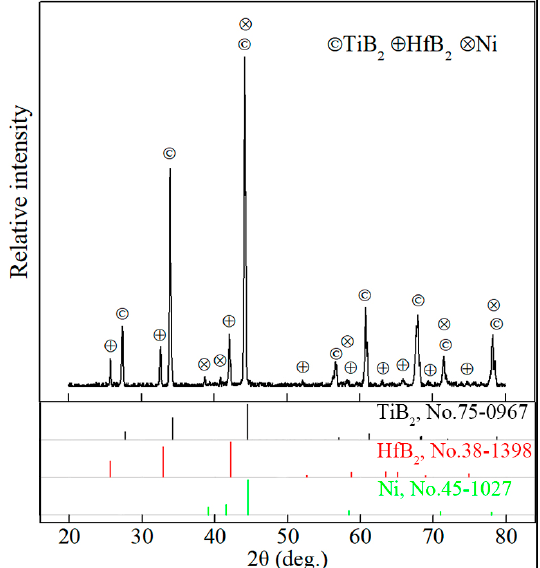
Figure 1. XRD pattern of TBHB before oxidation.